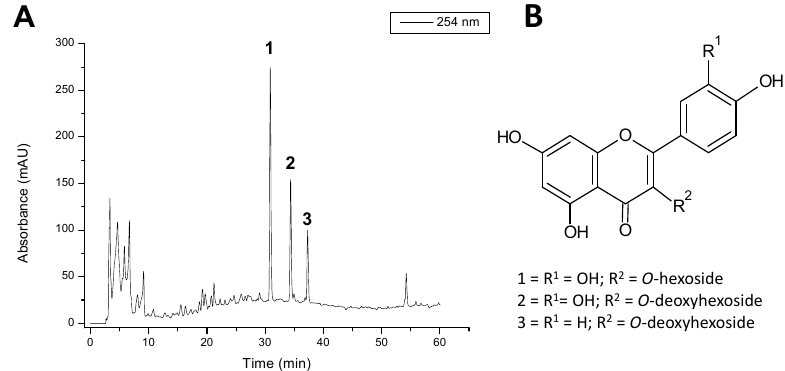
Figure 1. ( A ) Analytical High Performance Liquid Chromatography coupled to Photodiode Array Detector (HPLC-PAD) chromatogram recorded at 254 nm of hydroalcoholic extract of C. sicyoides. Mobile phase was ultrapure H 2 O (eluent A ) and MeOH (eluent B ), both containing 0.1% of formic acid. The parameters were as follows: the gradient ratio was 5%–100% of B in A in 60 min; the injection volume was 20.0 μ L; the column temperature was 25 °C (Phenomenex Luna ® C18—250 mm × 4.6 mm i.d., 5 μ m) and the flow ratio was 0.8 mL/min; ( B ) Structures of the compounds identified using HPLC-PAD-MS (Mass Spectrometer): 1, quercetin-3- O -hexoside; 2, quercetin-3- O - α -deoxyhexoside; and 3, kaempferol-3- O -deoxyhexoside.